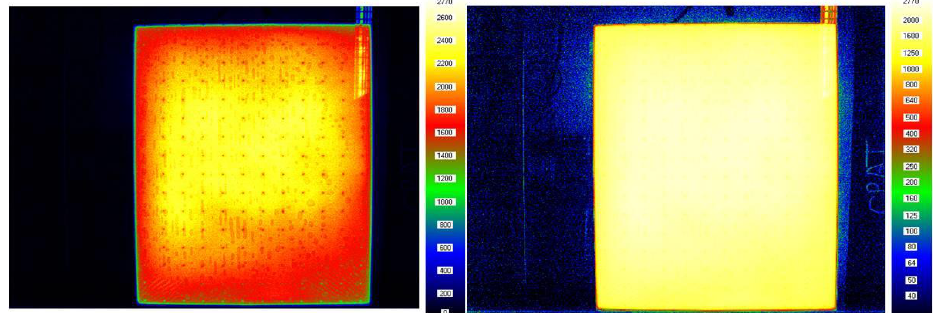
Figure 7. Mapping of the luminance for the 36 × 46 cm Planilum© , 250 mbar, pulse amplitude 2000 V, 20 kHz, on the right log scale on the left linear scale. 10 replicates, standard deviation 10%.